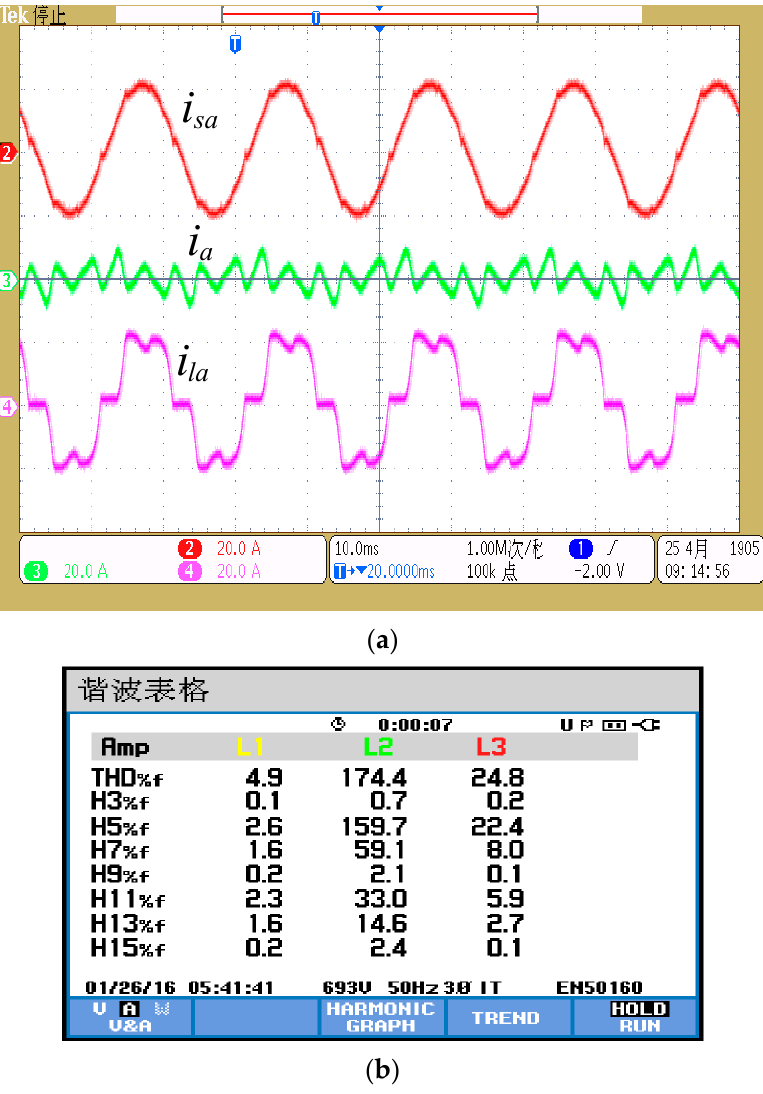
Figure 12. Harmonic compensation results without FD compensation: ( a ) Source (L1), compensating (L2), load (L3) current waveforms; ( b ) Harmonic distortion rate graph.